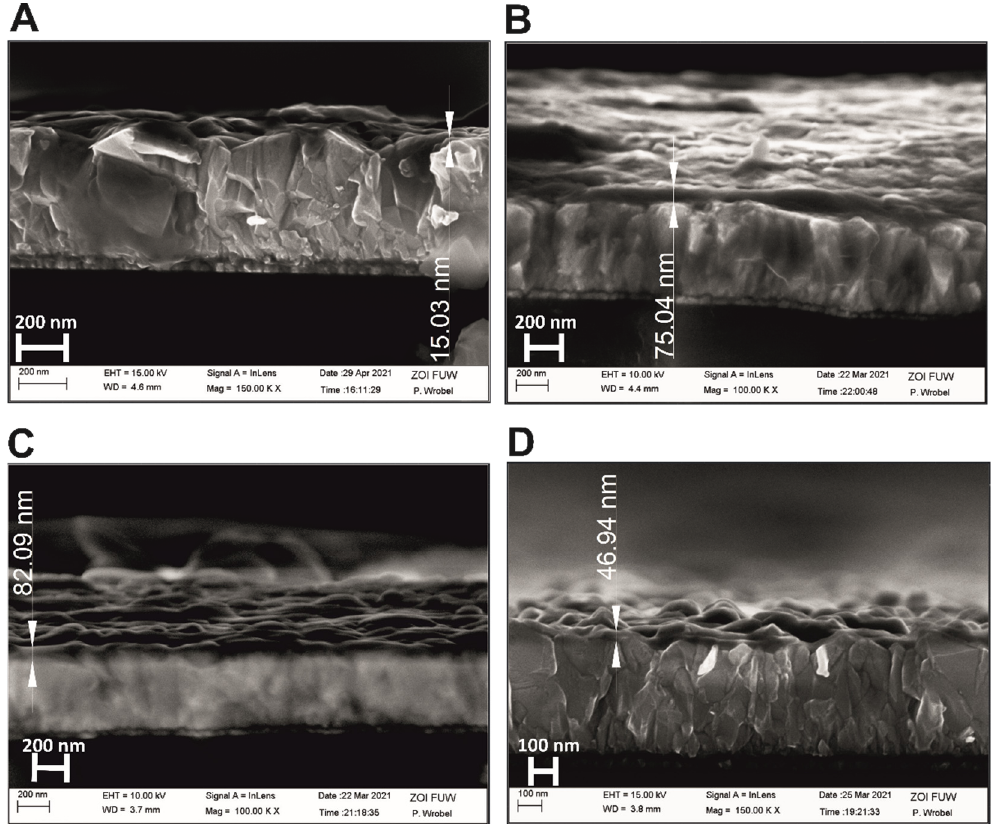
Figure 4. Cross-sectional imaging using scanning electron microscopy of glass/FTO/SLG electrodes functionalized with: ( A ) pyr-NTA-Ni SAM (d = 15 nm); ( B ) pyr-NTA-Ni/PSI (d = 97.5 nm); ( C ) pyr-NTA-Ni/cyt c 553 /PSI (d = 101 nm); and ( D ) pyr-NTA-Ni/His 6 -PsaD-PSI (d = 83 nm) nanoconstructs. d, cross-sectional thickness.